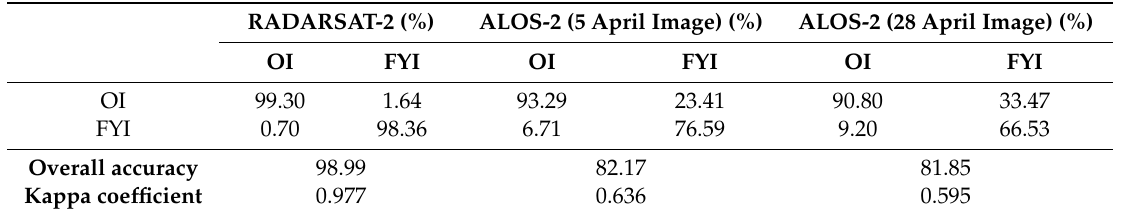
for the RADARSAT-2 image. The overall accuracy drops down to 82.17% (Kappa = 0.636) and 81.85% (Kappa = 0.595) for the two L-band ALOS-2 images, respectively (Table 5). Table 5. Validation of the FYI and OI classification results for different SAR